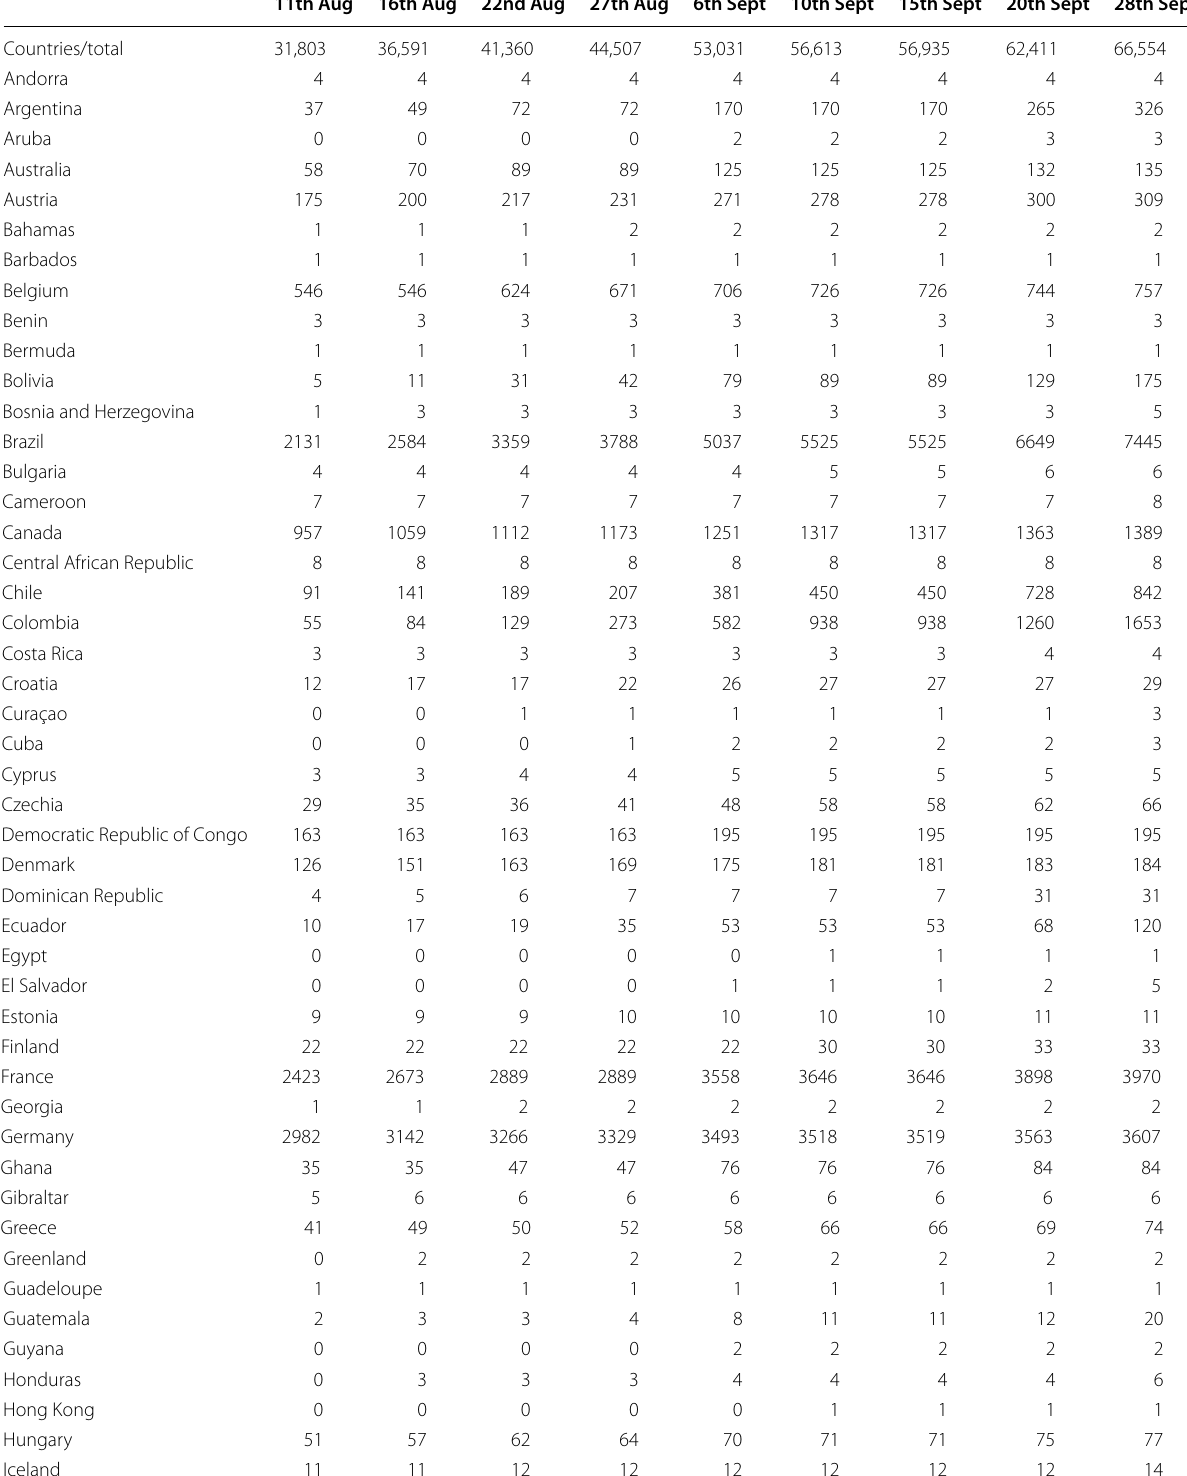
Table 2 Countries with reported cases of spreading monkeypox based on centers for disease control and prevention from 17th